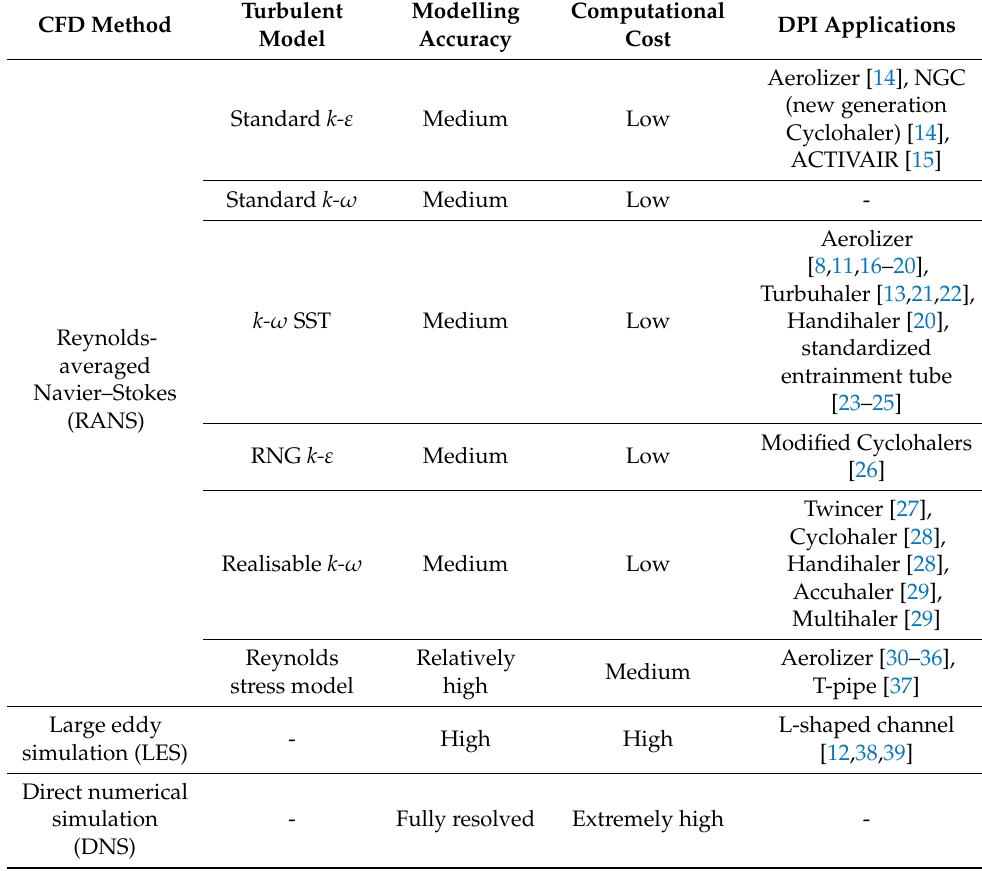
Table 1. Comparison of different computational fluid dynamics (CFD) methods for DPI